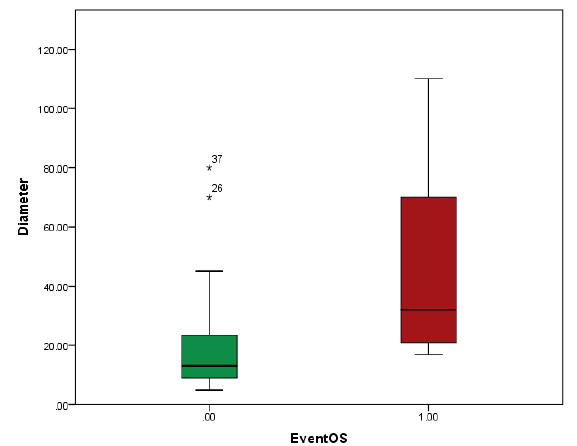
Figure 4. Analysis of the dimension of metastases regarding the fatal event.